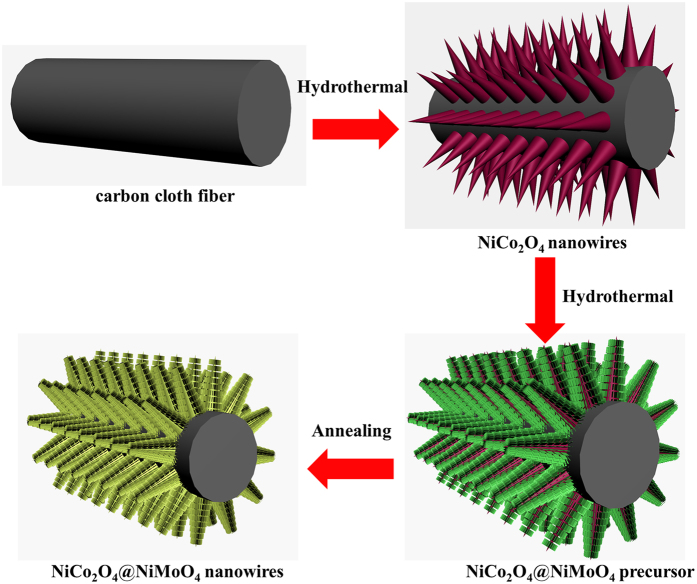
Schematic formation process of CC@NiCo2O4@NiMoO4 integrated electrode.